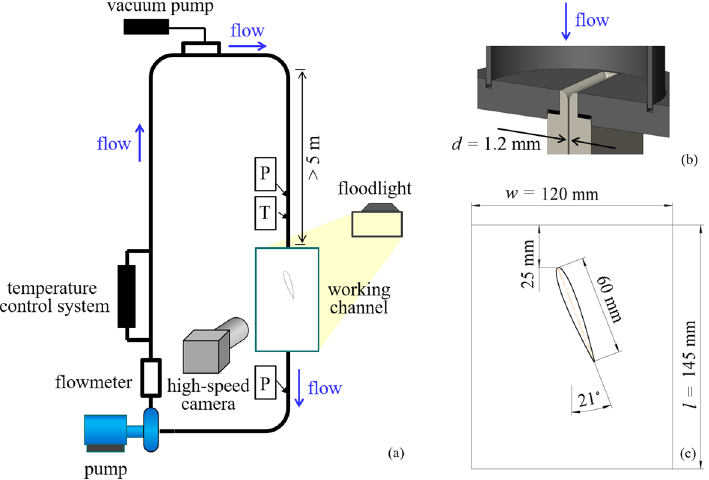
Figure 1. ( a ) Experimental loop. ( b ) Shape of the working channel inlet. ( c ) Scheme of the working